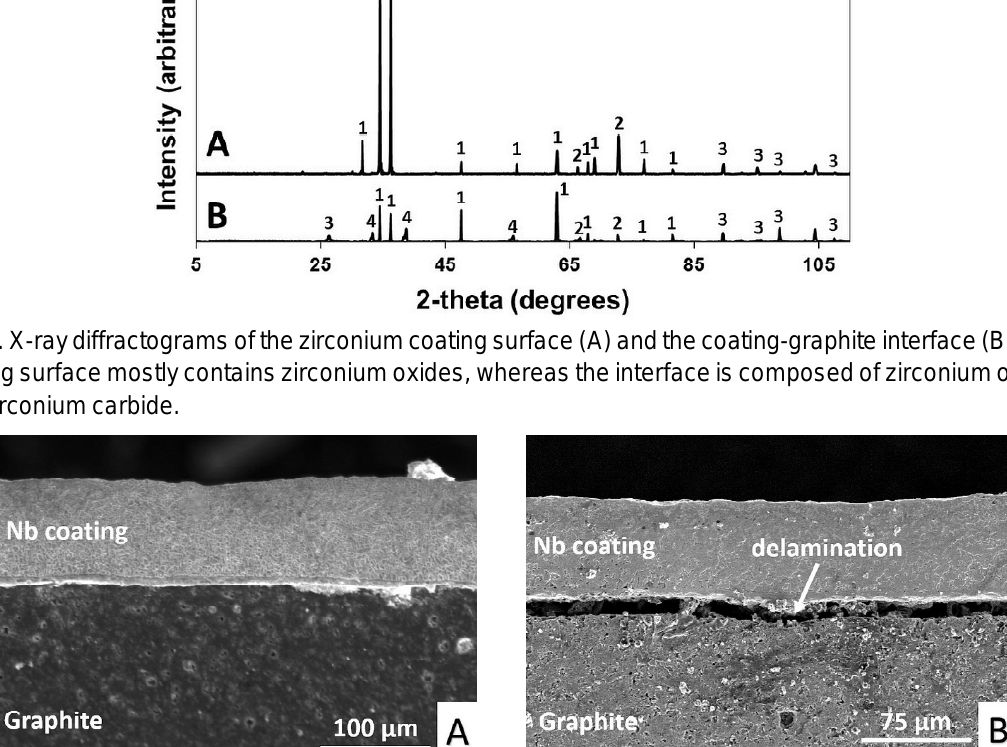
+ 30 g NH HF + 20 ml 3 4 2